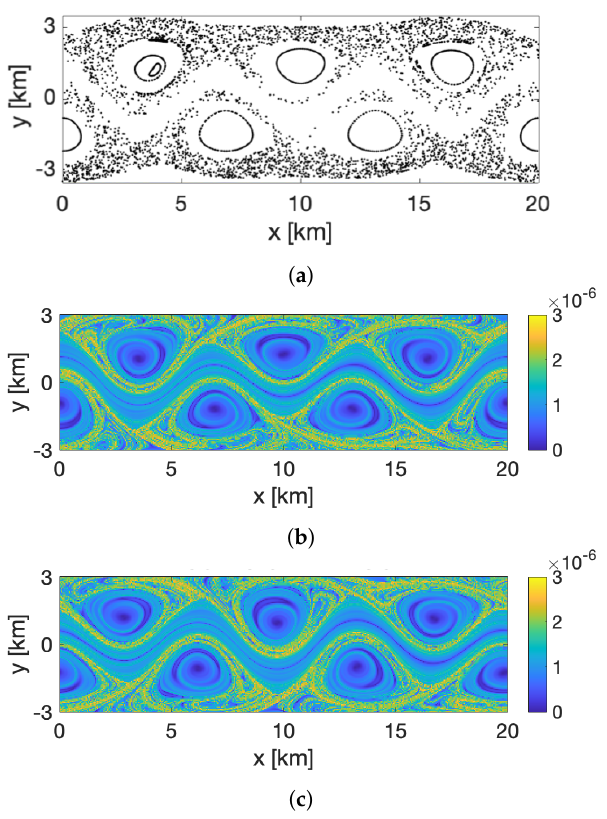
Figure 2. ( a ) Poincaré map for the periodic Bickley Jet flow, computed over 1000 perturbation periods. ( b ) Forward- and ( c ) Backward-FTLE field, computed over 30 peturbation